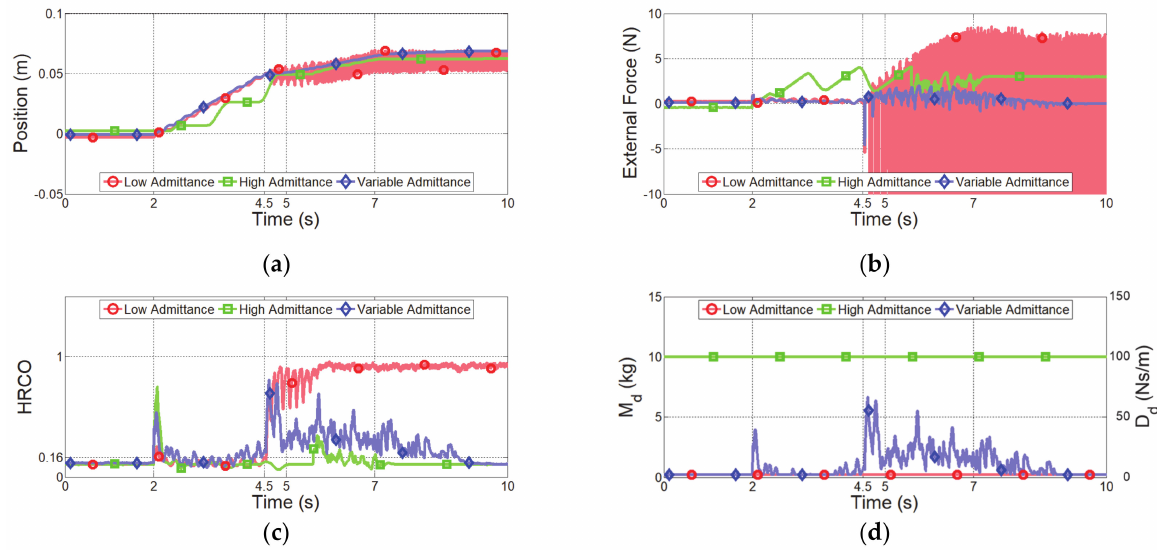
Figure 12. Experimental results of controllers for collision with virtual object. ( a ) End-effector position along x axis, ( b ) external force along x axis, ( c ) HRCO output, and ( d ) admittance